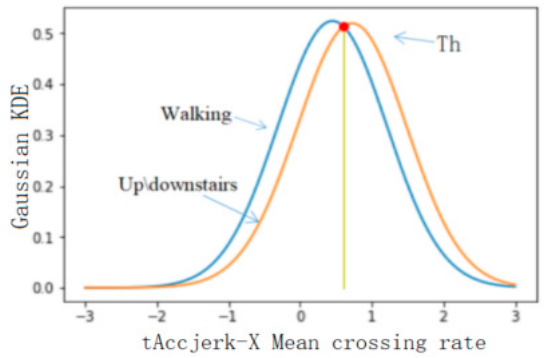
Figure 7. Probability distribution of walking and up-downstairs.